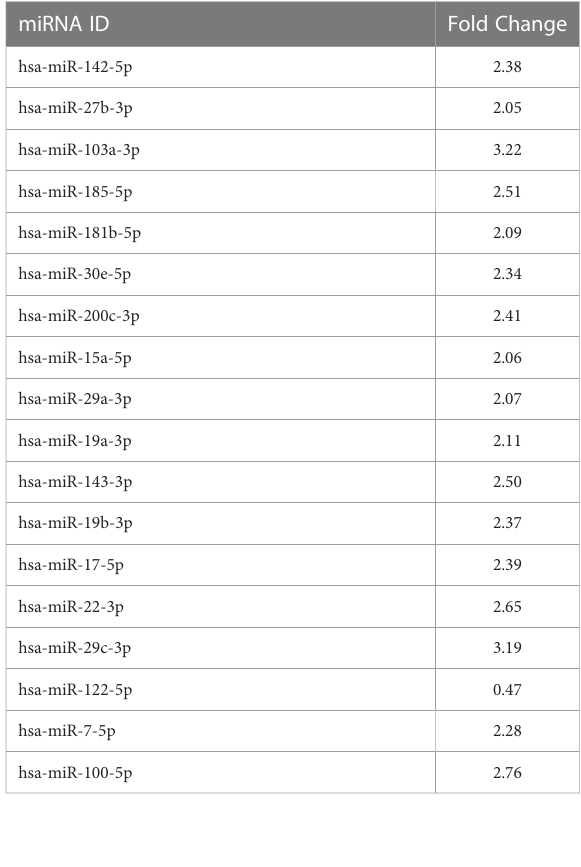
TABLE 2 Fold change values of dysregulated miRNAs in sEV PBDE+LPS . miRNA ID Fold Change